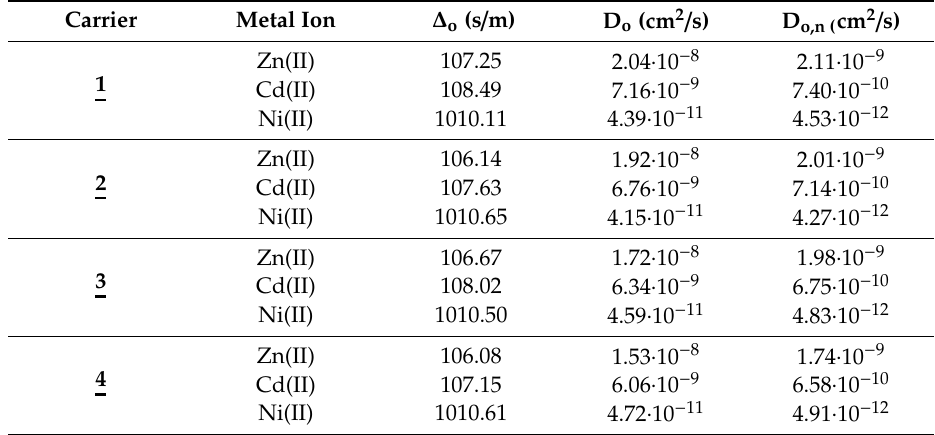
Table 4. Di ff usion coe ffi cients normalized for competitive transport of Zn(II), Cd(II), and Ni(II) ions through PIMs doped with alkylimidazole ( 1 – 4